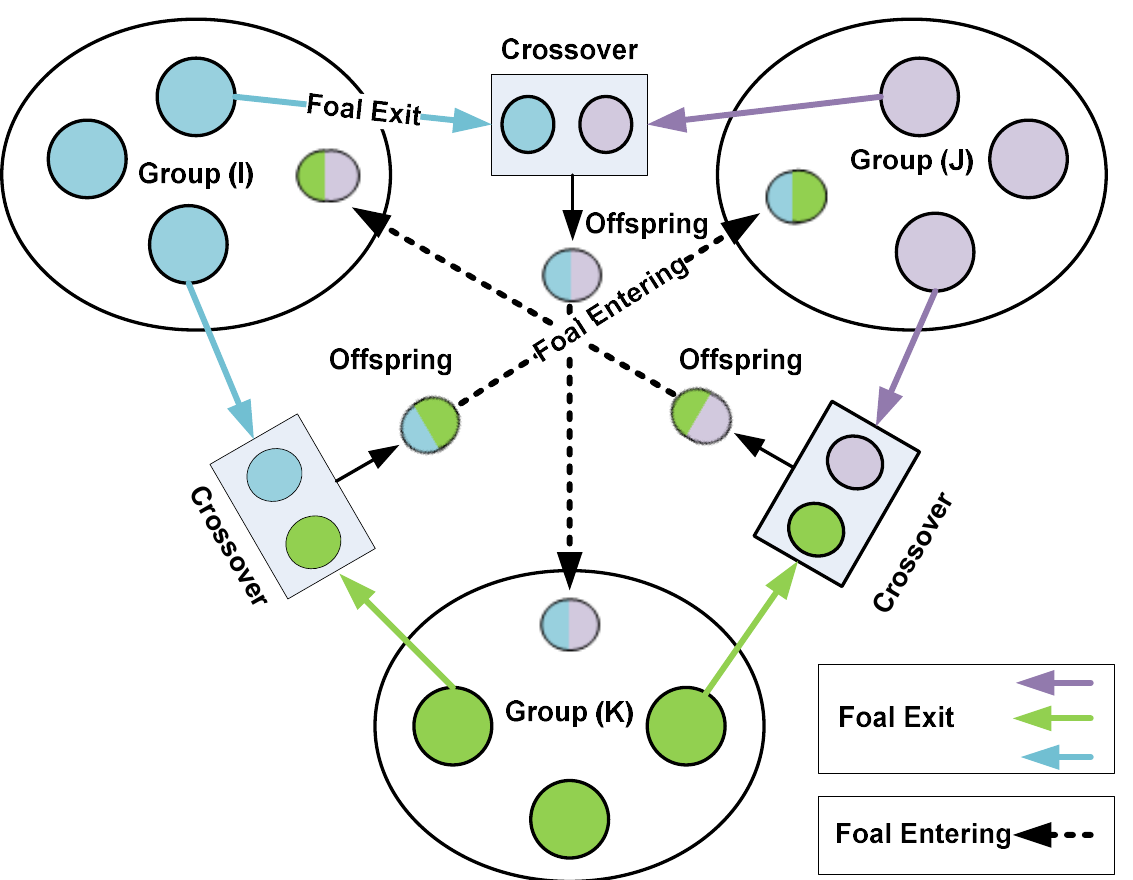
Figure 7. Foals’ behavior when leaving their original group and joining a new